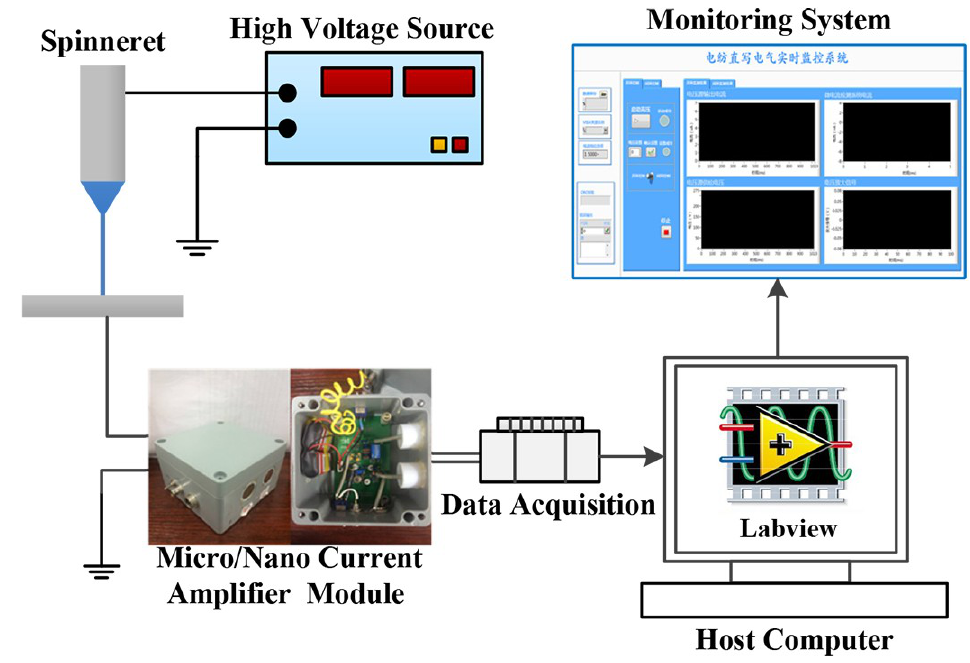
Figure 1. Micro/nano current measurement system of electrohydrodynamic direct-writing.